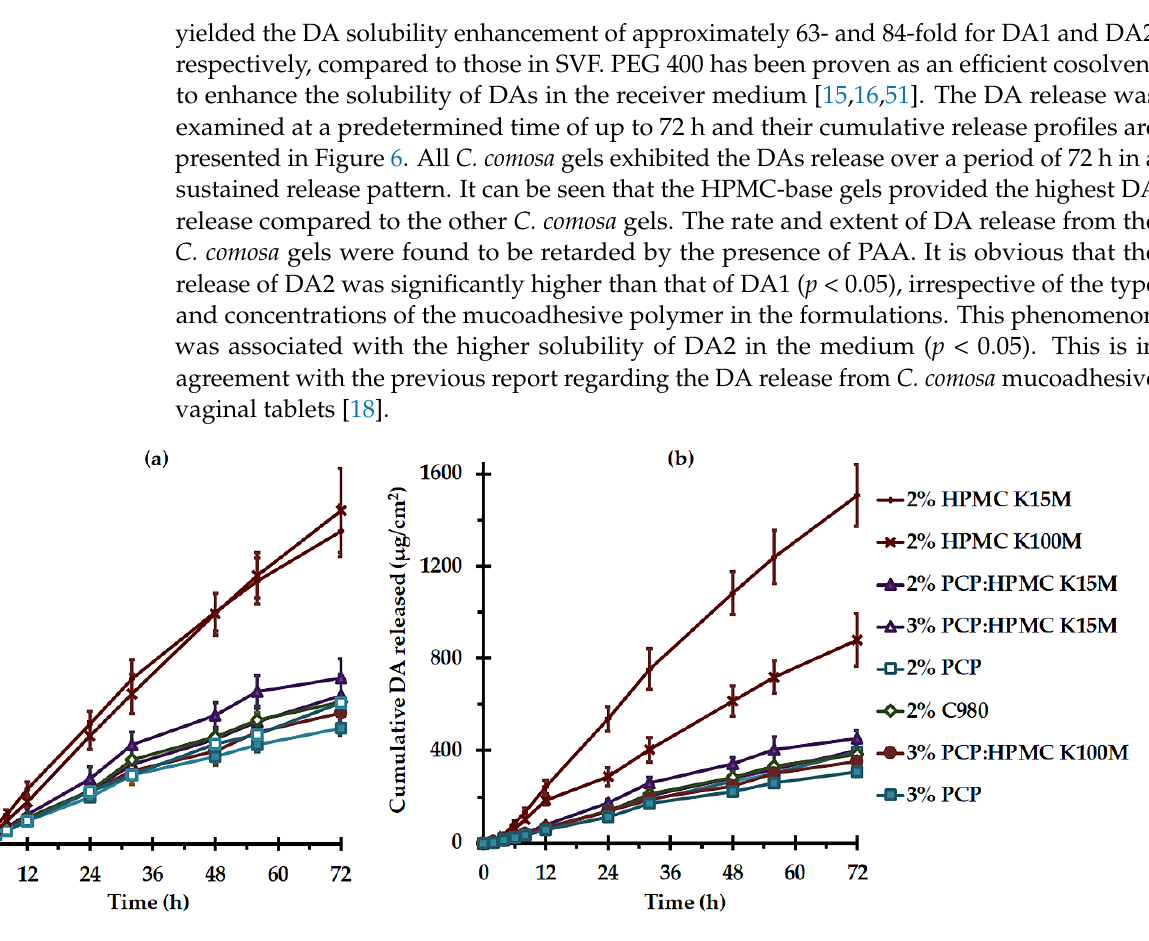
Figure 6. In vitro release behaviors of DA1 ( a ) and DA2 ( b ) from C. comosa mucoadhesive gels (mean ± SD, n = 4).